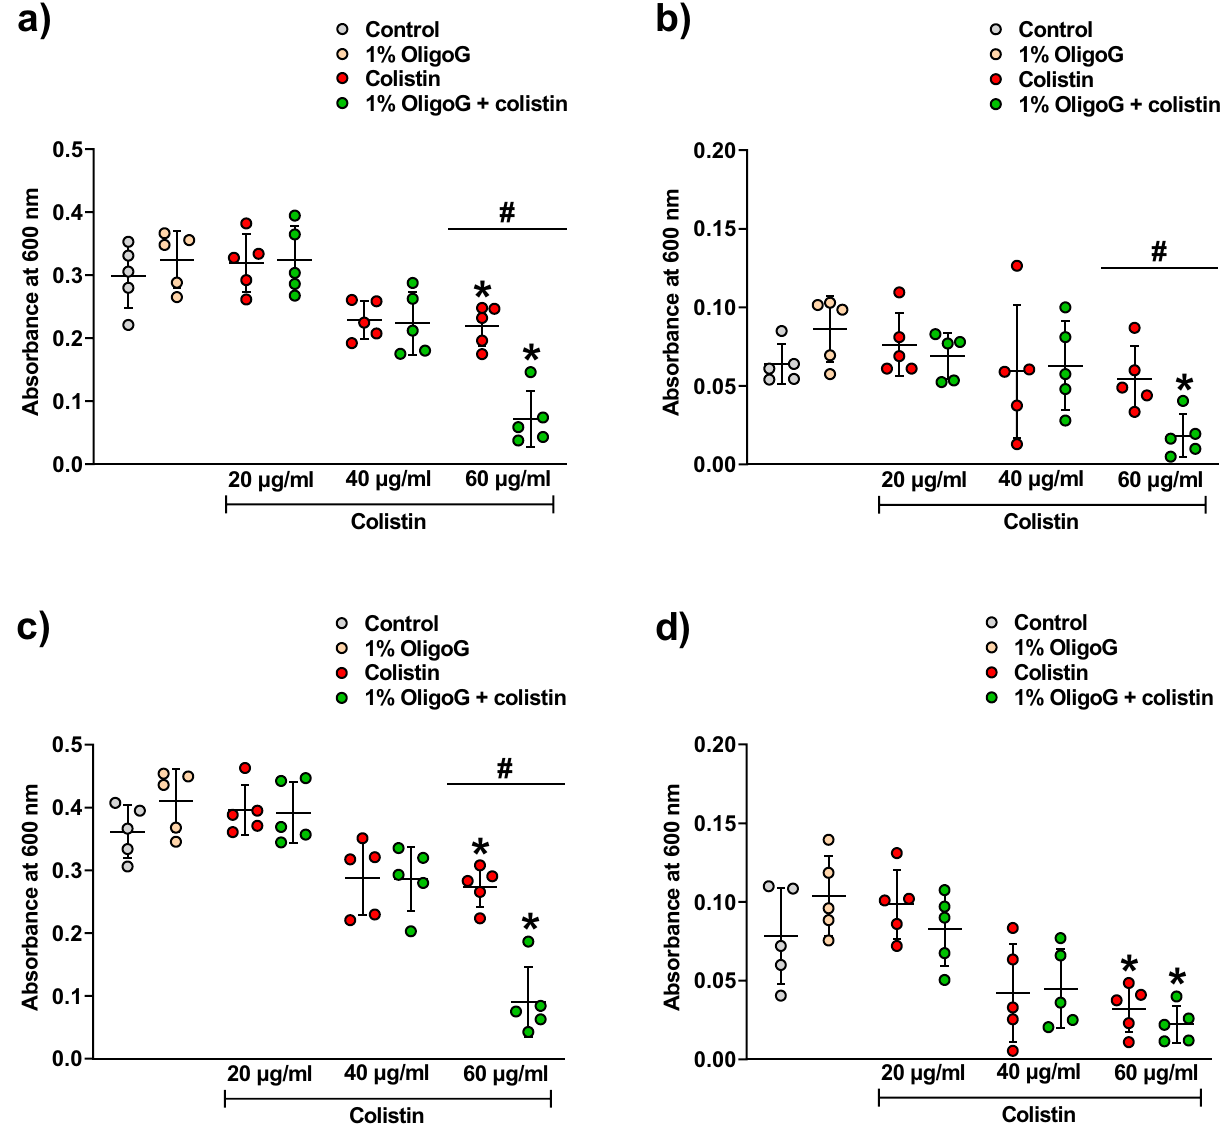
Figure 5. Analysis of planktonic (supernatant) and biofilm growing cells of 24 h P. aeruginosa NH57388A, following 24 h treatment with colistin ± 1% OligoG added onto the artificial sputum medium surface (± SD; n = 5). ( a ) Planktonic bacteria from the biofilm supernatant. ( b ) Planktonic bacteria after biofilm washing. ( c ) Total planktonic bacteria (a + b). ( d ) Attached biofilm bacterial population. Significant difference is indicated by *, where * p < 0.05 compared to untreated control and # p < 0.05 between two groups as indicated by horizontal